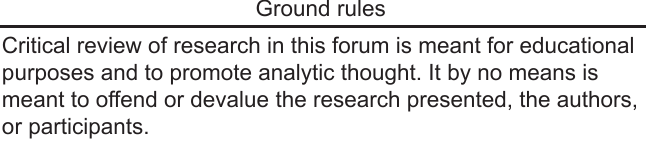
Table. Ground rules shared at the beginning of each online journal club.